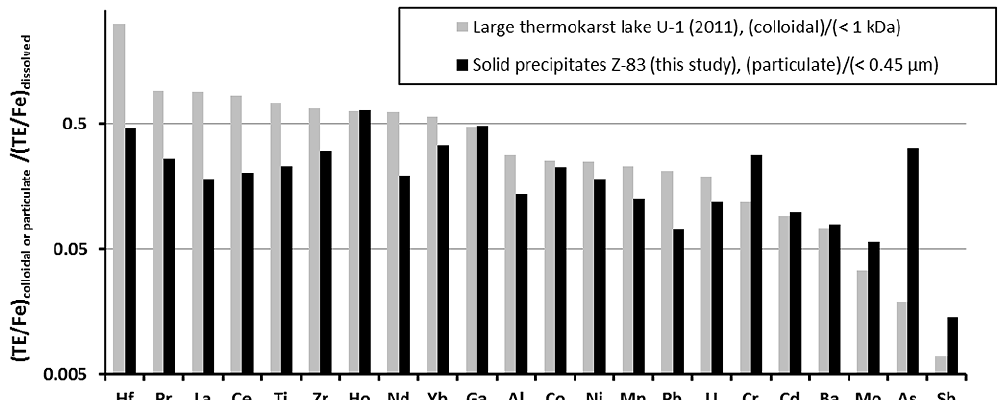
Figure 6. Comparison of the distribution coefficients of a trace element (TE) normalized to Fe between the solid precipitates collected in June from the ice surface of a large lake (Fig. S6) and filtered water (black columns) and those measured between colloids (1kDa – 0.45µm) and the LMW < 1kDa fraction in a large thermokarst lake (Pokrovsky et al., 2011) of the discontinuous permafrost zone (grey